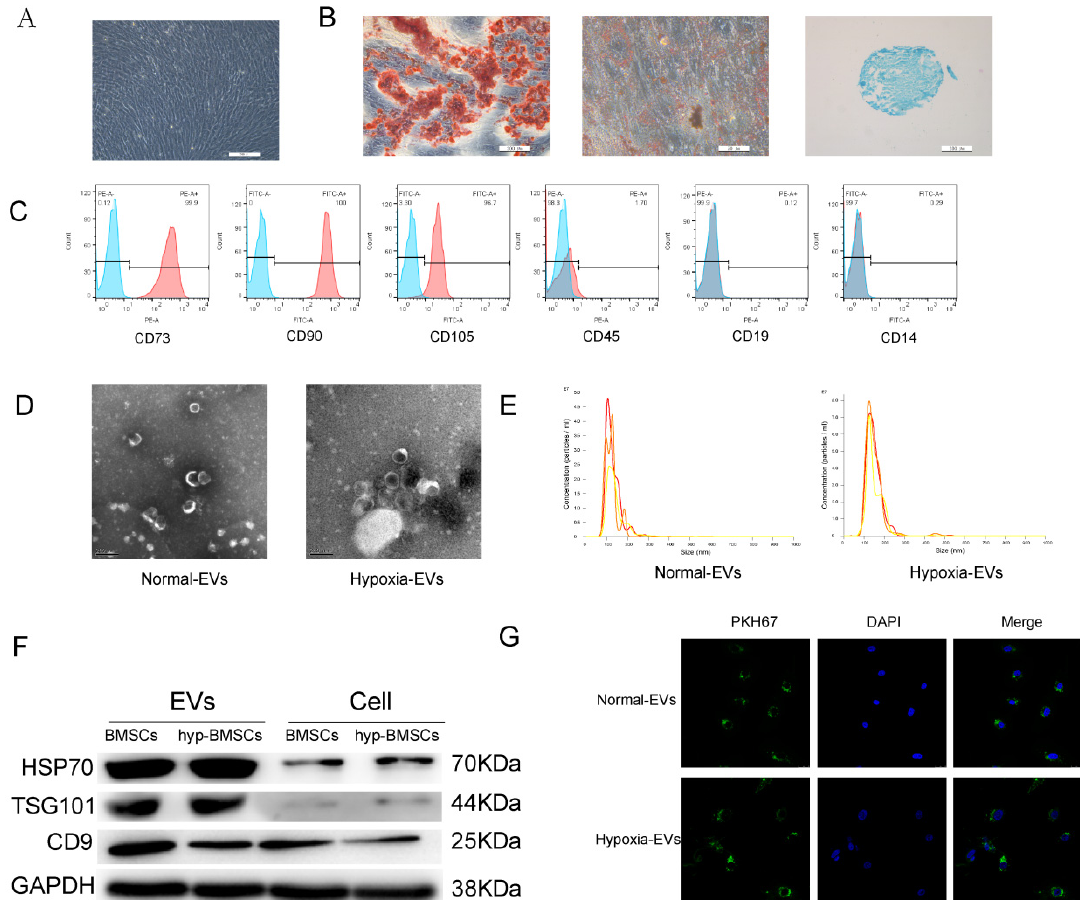
Figure 1. Identification of BMSCs and BMSC-EVs. ( A ) BMSCs showed a spindle-like shape (Scale bar = 200 μ m). ( B ) BMSCs were induced to differentiate into osteoblast (Scale bar = 200 μ m), adipose cells (Scale bar = 50 μ m), and chondroblast cells (Scale bar = 200 μ m). ( C ) Flow cytometry analysis of the cell surface markers on BMSCs. ( D ) Morphology of the exosomes under transmission electron microscopy. (Scale bar = 200 nm). ( E ) Particle size distribution of BMSC-EVs as measured by Nanosight. ( F ) Western blot analysis of the EV-specific CD9, CD70, and TSG101 proteins. ( G ) Detection of BMSC-EVs uptake by chondrocytes. PKH67 is shown in red, and DAPI is shown in blue (Scale bar = 20 μ m).